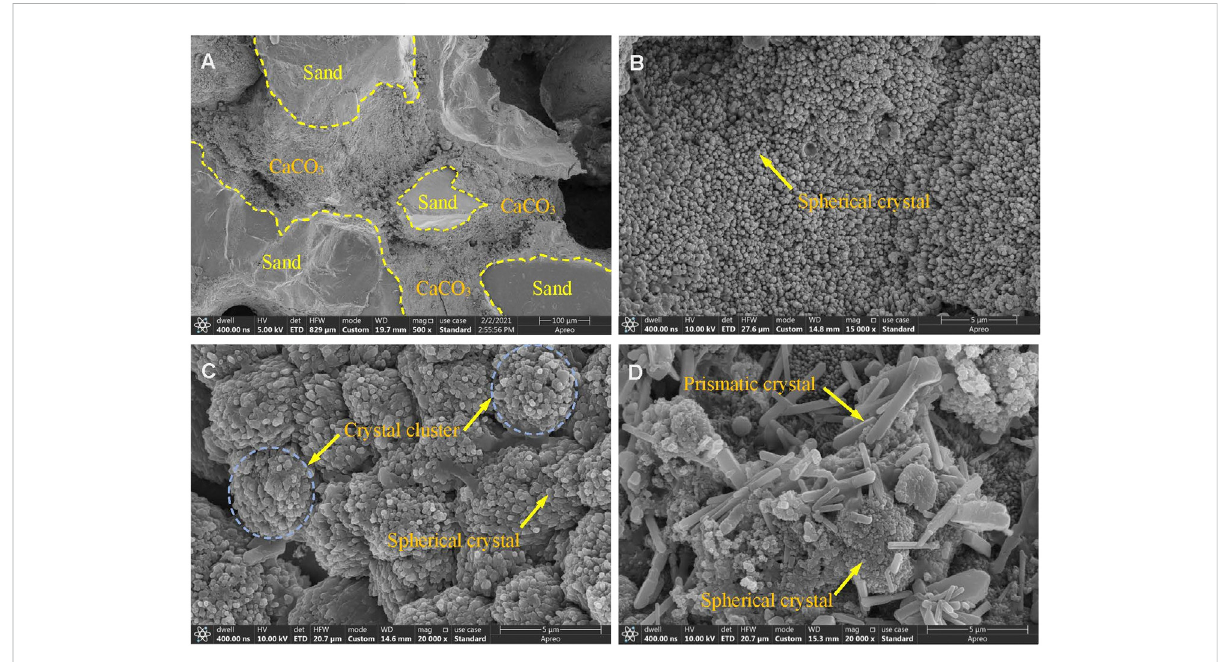
FIGURE 9 SEM of treated samples: (A) , (B) , (C) , and (D) are the results of samples G5, G3, G6, and G9, respectively.